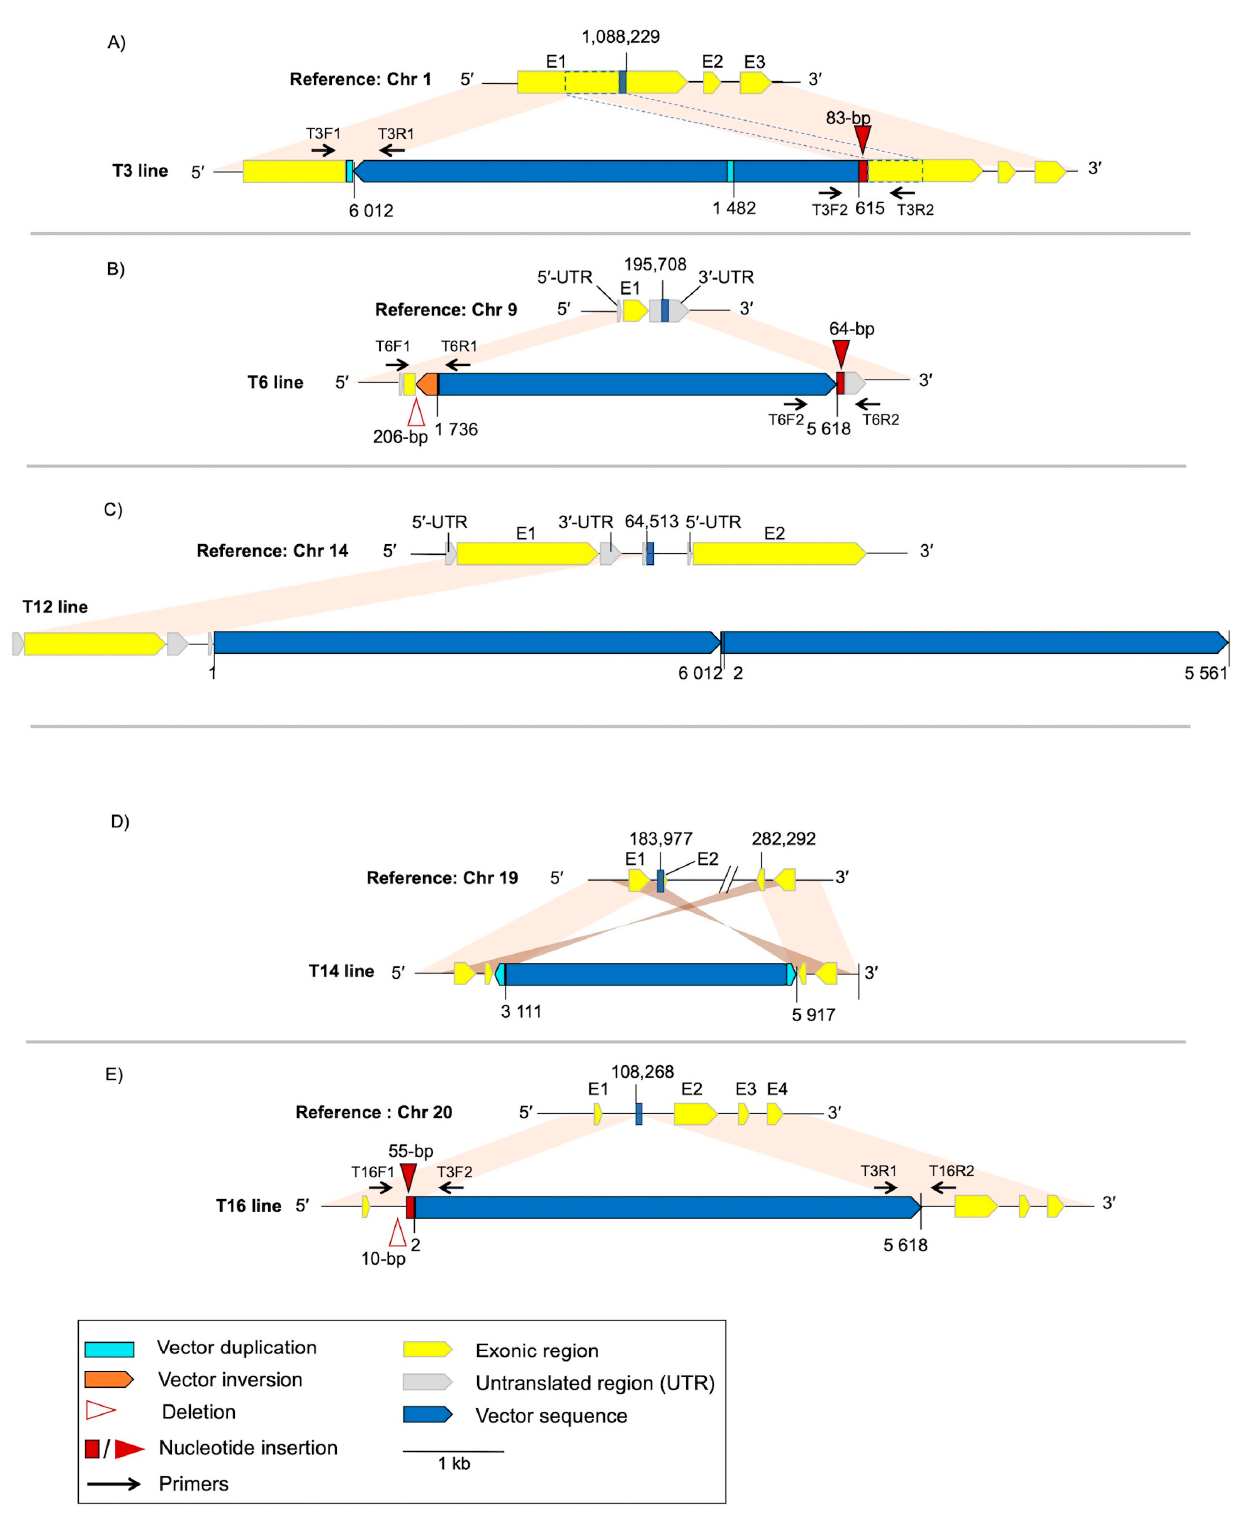
Figure 4. Schematic illustration of the vector integration sites and associated structural variations in contigs assembled from transformants compared to the reference genome. Homologous sequences between the reference and the clonal lines are connected by colored blocks (light orange, same orientation; dark orange, inverse orientation) ( A ) T3 line. ( B ) T6 line. ( C ) T12 line; the entire vector sequence occurs twice in tandem at the end of the contig. ( D ) T14 line. Note that the map of the reference chromosome 19 sequence shows two distant regions separated by a break. ( E ) T16 line. Primers (black arrows) targeting the flanking regions have been designed to confirm the insertion–deletion events (red) in the T3, T6 and T16